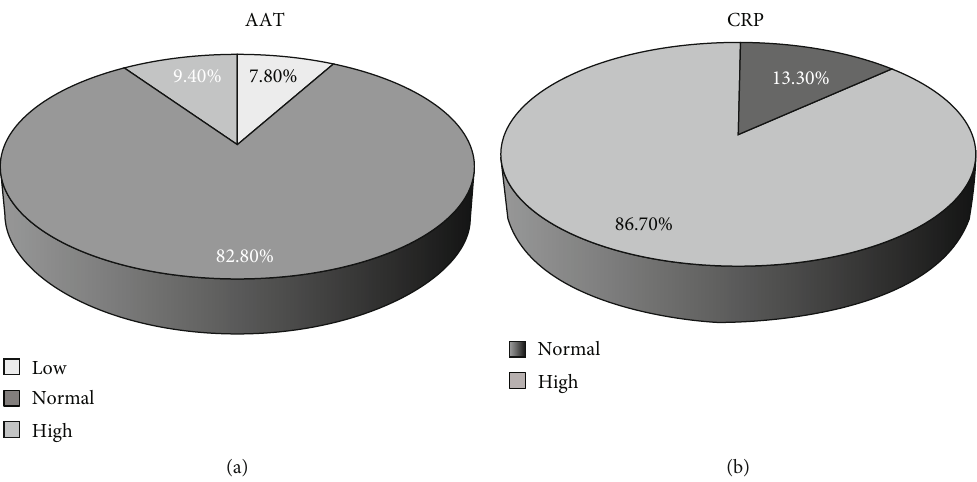
Figure 2: Pie charts showing percentages of AAT and CRP in patients included in this study. (a) Percent of patients in low ( ≤ 90 mg/dl), normal (90-200mg/dl), and high ( ≥ 200mg/dl) ranges of AAT ( n = 64 ). (b) Percent of patients in normal ( < 6mg/l) and high ( ≥ 6mg/l) ranges of CRP ( n = 60 ). Abbreviations: AAT: alpha-1 antitrypsin; CRP: C-reactive